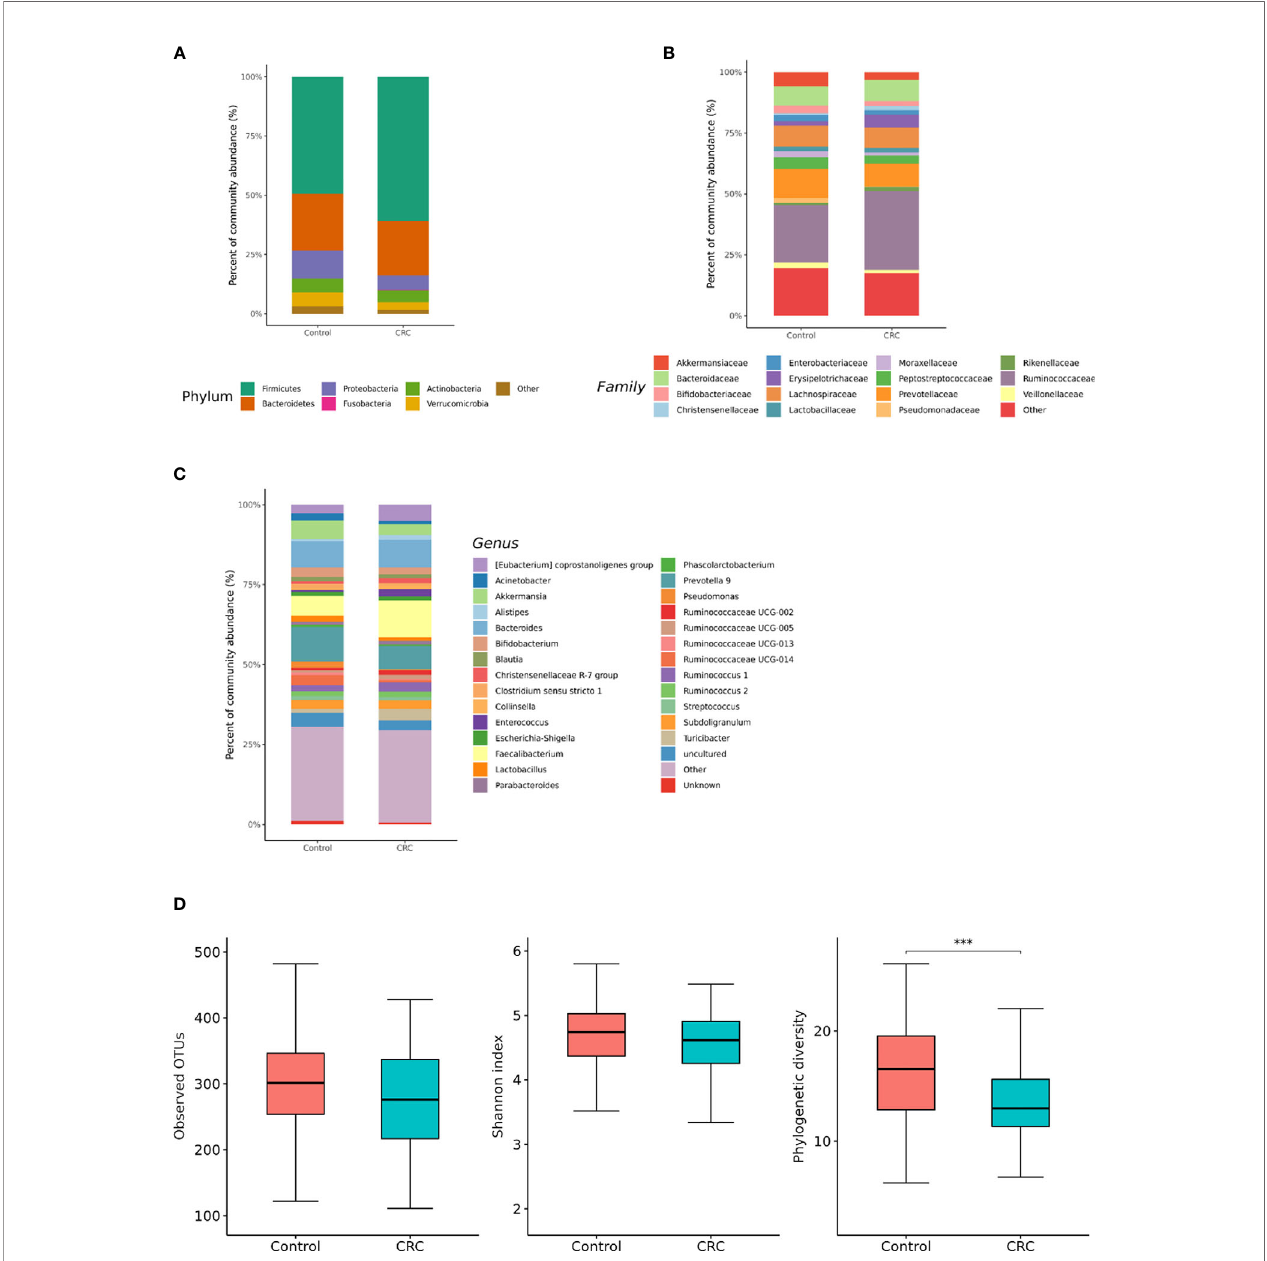
FIGURE 4 | Relative abundance plots of gut microbe-derived extracellular vesicles of control (n = 158) subjects and CRC subjects (n = 70) (A) at the phylum, (B) family, and (C) genus levels. (D) Boxplots of alpha diversity indices comparing CRC with control in gut microbe-derived extracellular vesicles. *** p < 0.005. CRC; colorectal cancer, OTU; operational taxonomic